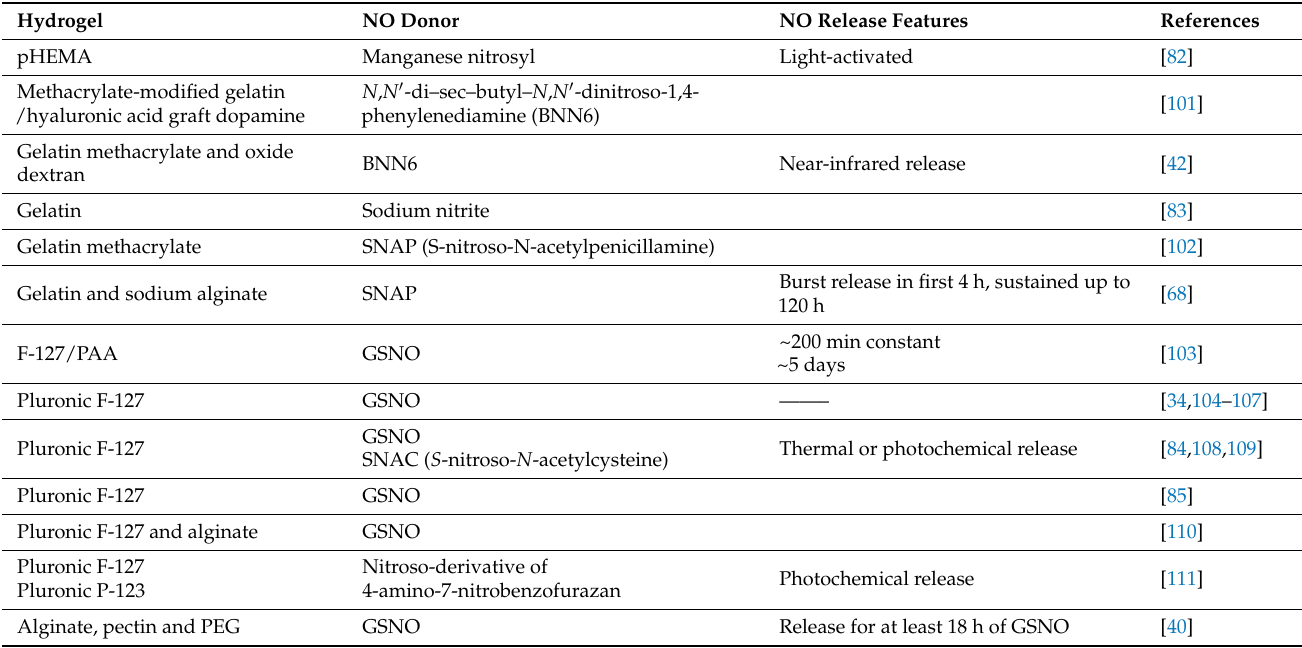
Table 3. NO-releasing hydrogels based on physically adsorbed NO